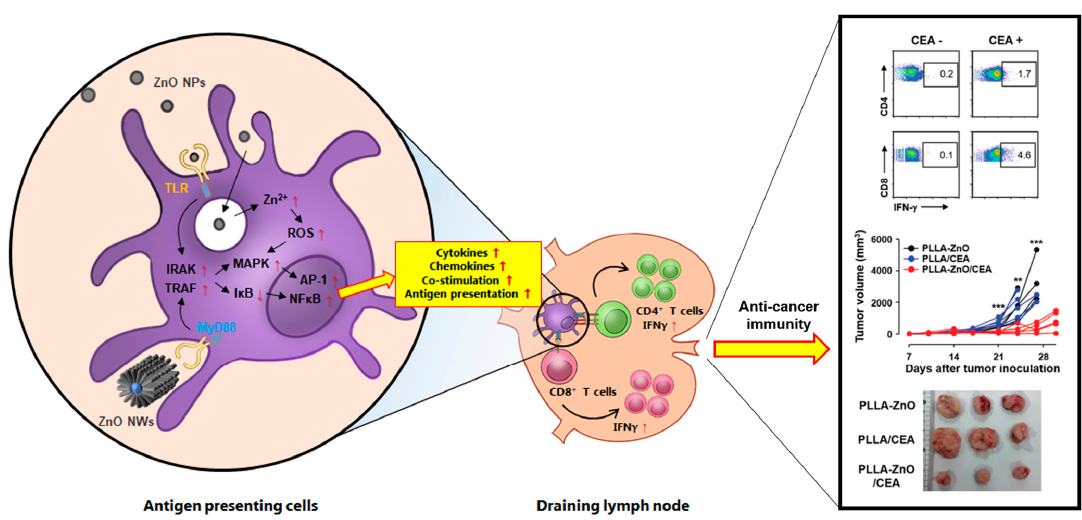
Figure 3. Schematic diagram of the proposed effects of ZnO nanocomposites on antigen-presenting cells and their potential role in inducing T cell responses in draining lymph node. Various forms of ZnO nanocomposites (e.g., ZnO NPs and NWs) can stimulate inflammatory responses in antigen-presenting cells via TLR recognition or direct endocytosis/phagocytosis, which subsequently initiates immune signaling cascades. TLR stimulation by ZnO nanocomposites can upregulate downstream molecules IRAK and TRAF, and enhance subsequent MAPK pathways. Then, the inhibitor of NF κ B, I κ B, is degraded and NF κ B is activated accordingly. Endocytosed ZnO nanocomposites transported into the acidic lysosomes dissociate into Zn 2+ ions and ionic form of zinc disrupts oxidative balance, increasing ROS generation. Ultimately, upregulation of pro-inflammatory signaling pathway and ROS generation enhance the production of pro-inflammatory cytokines and chemokines, and increase the surface expression of co-stimulatory and antigen presenting molecules. Stimulated antigen presenting cells migrate into draining lymph node and prime naïve CD4 and CD8 T cells into effector T cells, which can initiate both humoral and cell-mediated immune responses against specific antigen associated with ZnO nanocomposites. A representative example of anti-cancer immunity induced by ZnO nanocomposites coated with a tumor antigen, carcinoembryonic antigen (CEA), is presented in